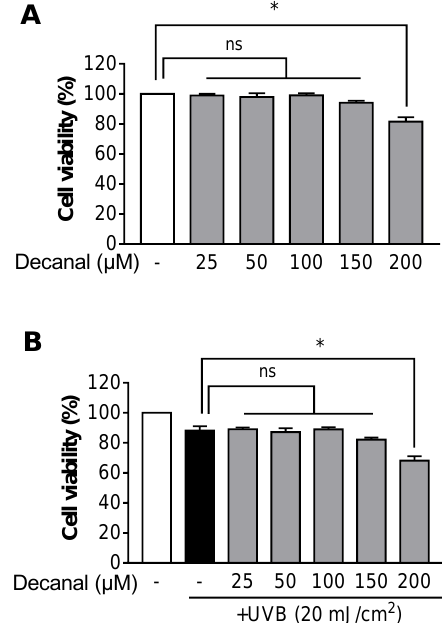
Figure 1. The effect of decanal on cell viability in Hs68 dermal fibroblasts. The cell viability of